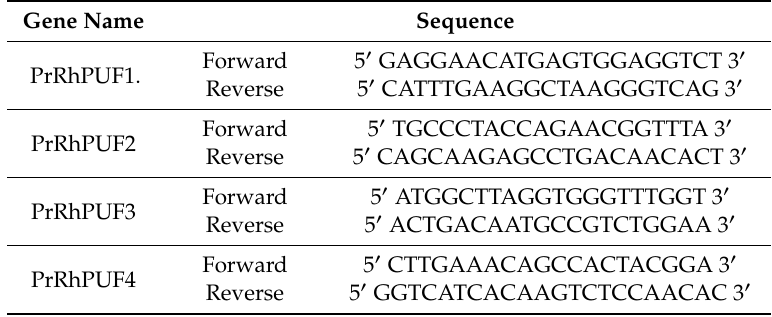
Table 1. Specific PCR primers of each RhPUF